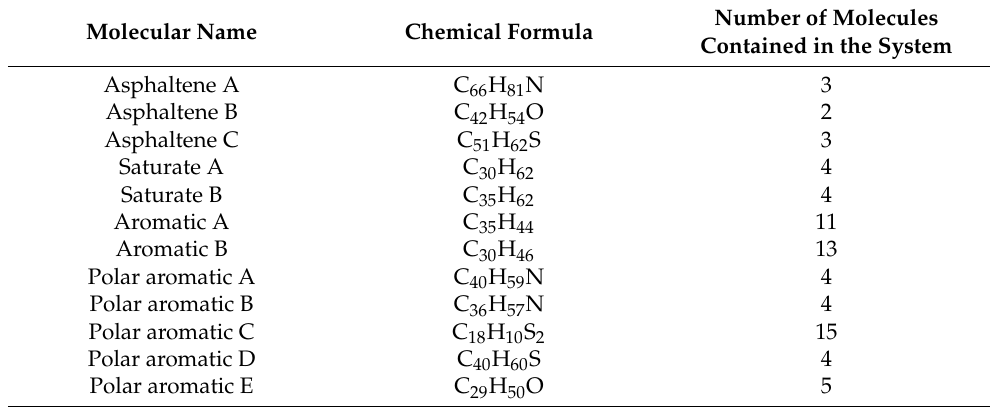
Table 1. Composition of the all-atom molecular model